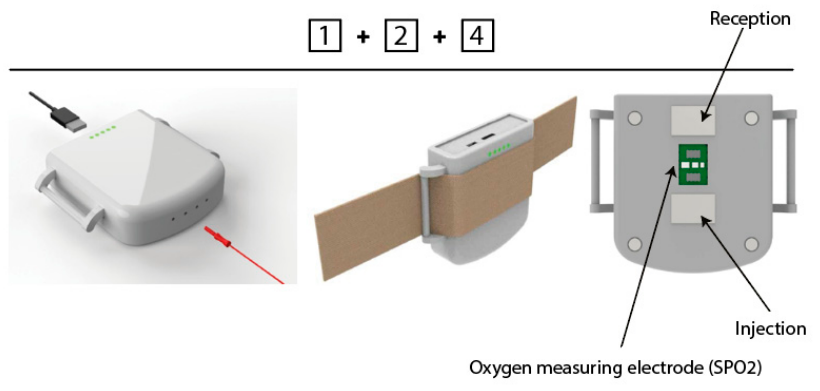
Figure 6. First 3D rendering Impedance Eye Recording (IER).